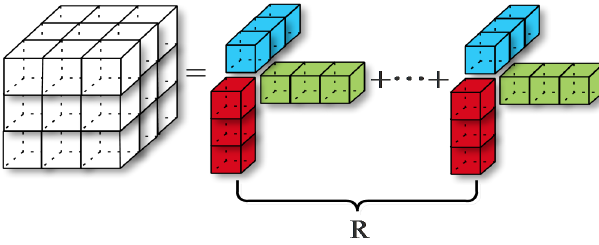
Figure 2. Visualization of the separated convolution. The white cube is the original rank R3D convolutional kernel, and the 1D kernels are the Canonical Polyadic (CP) decomposition of the white